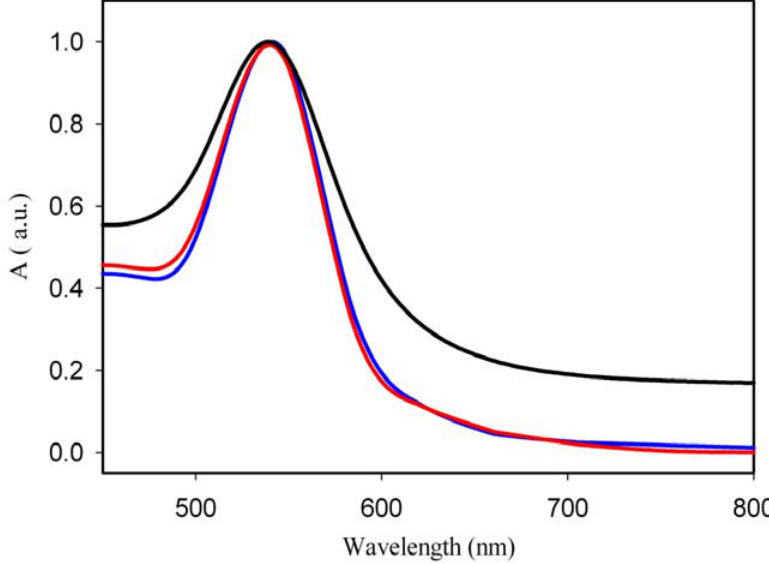
Figure 1. Comparison between the observed ( black ) and simulated optical properties ( blue for the DDA-simulated curve and red corresponding to Mie’s method) of Au-PMMA nanostructure. The curve corresponding to the experimental results corresponds to the MW-irradiated